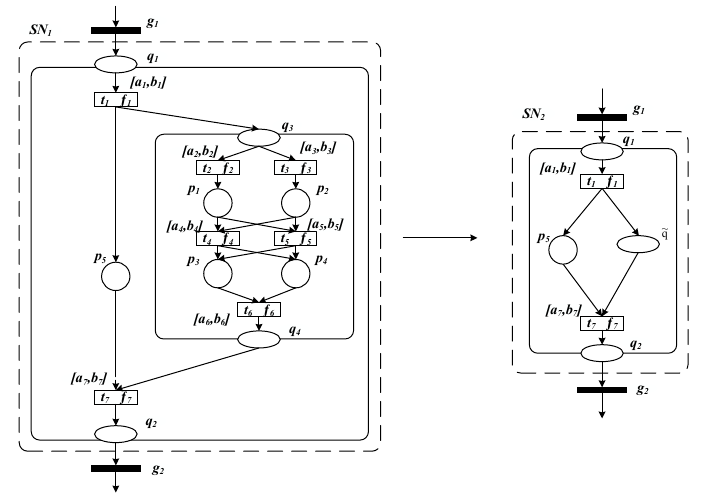
Figure 3. An example of Q-type internal subnet reduction rule.